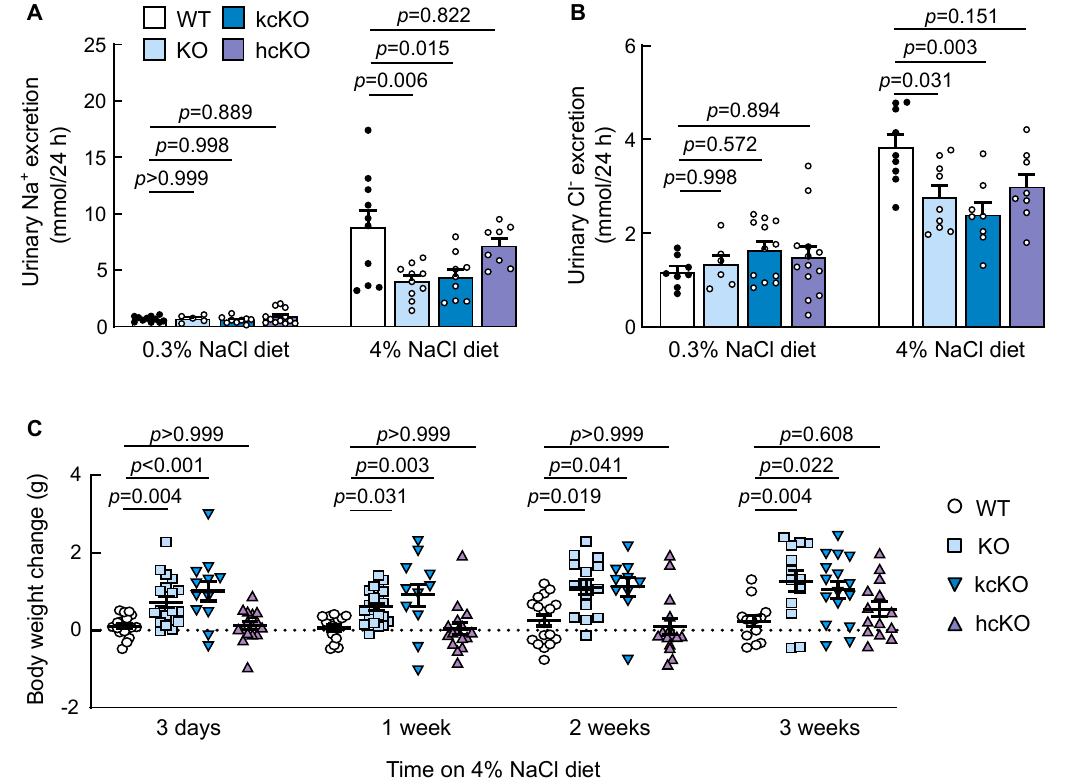
Figure 4. Urinary Na + and Cl − excretions and body weight change in corin kcKO mice. ( A , B ) Urinary Na + ( A ) and Cl − ( B ) excretion in WT (black dots), corin KO, kcKO, and hcKO (white dots) mice on 0.3% and 4% NaCl diet were measured. n = 5–13 per group. ( C ) Body weight changes in WT, corin KO, kcKO, and hcKO mice when 0.3% NaCl diet was switched to 4% NaCl diet. n = 10–21 per group. Data are mean ± SEM. P -values were analyzed by one-way ANOVA ( A ) or Kruskal–Wallis test ( B , C ). Consistent with the impaired urinary salt excretion when fed the 4% NaCl diet, the body weights of the male corin KO and kcKO mice were higher than those of the WT mice, whereas body weights were not significantly increased in the male corin hcKO mice (Figure 4C). Similar results of reduced urinary Na + and Cl − excretions and increased body weights were observed in the female corin KO and kcKO mice fed the 4% NaCl diet (Figure S5A–C). These results indicated that when fed a 4% NaCl diet, impaired urinary salt excretion causes water retention and body weight gains in mice lacking renal, but not cardiac,